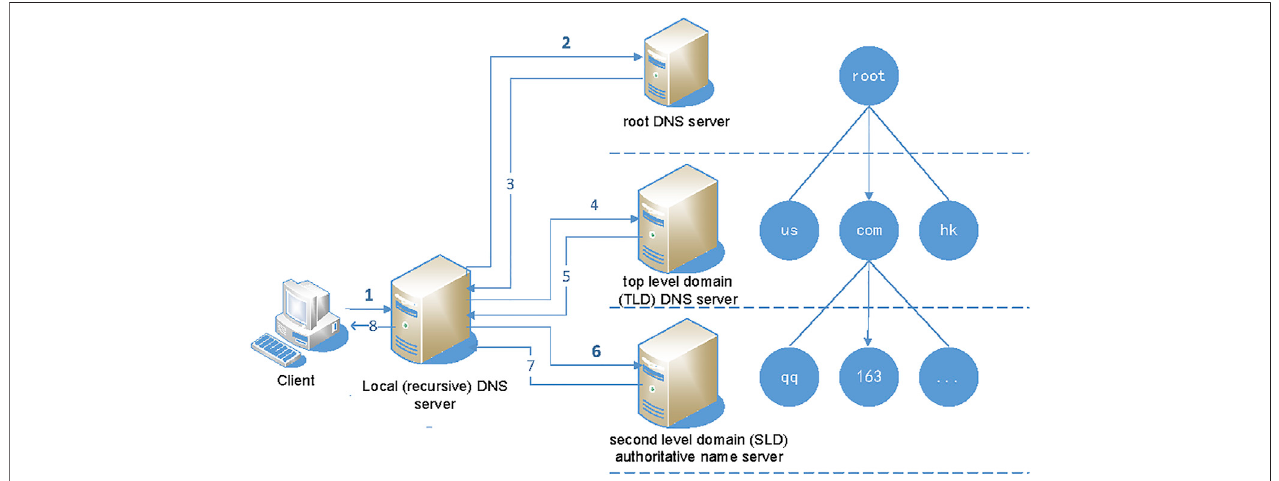
FIGURE 1 | DNS structure and domain name resolution fl